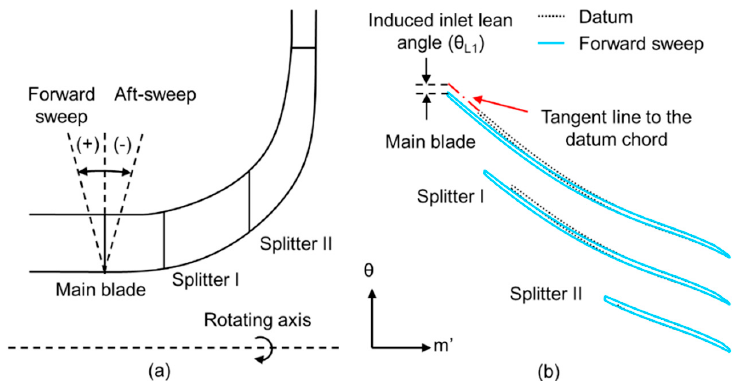
Figure 3. Swept geometry: ( a ) meridional view and ( b ) shroud sections of all blades.